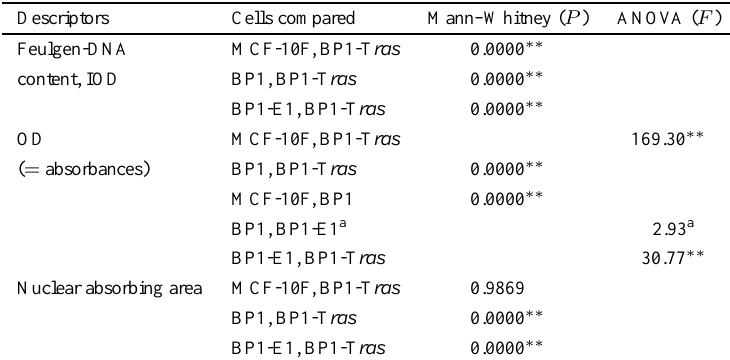
Comparison of nuclear image analysis parameters ( n = 200)